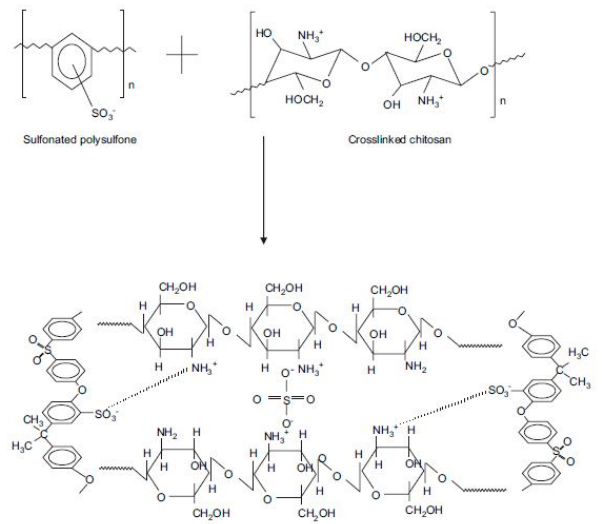
Figure 8. Schematic of CS and sulphonated polysulphone (PSF) blend membrane [127]. Copyright 2008, reproduced with permission from Elsevier.